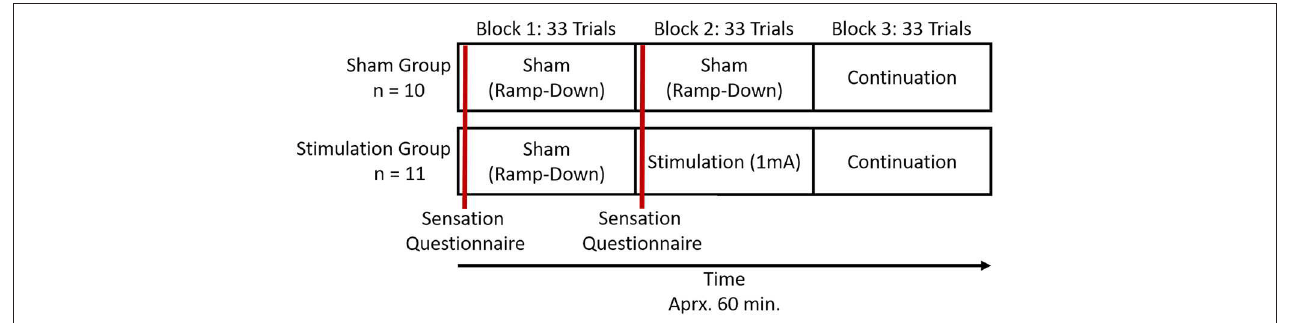
FIGURE 2 | Representation of trial and stimulation structure for the study.